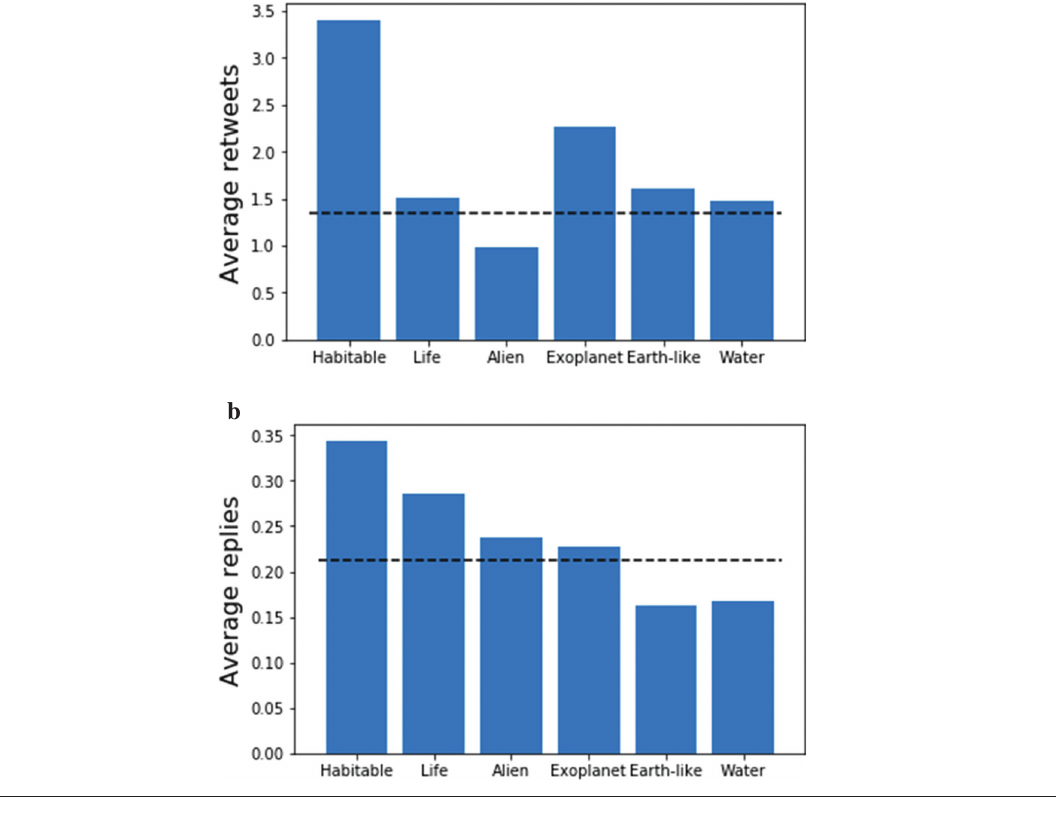
Figure 4. (a) The average number of retweets for tweets containing ‘Proxima Centauri’, containing certain keywords; (b) similar, but for replies. In each case, the dashed line indicates the average activity for all ‘Proxima Centauri’ tweets (Source: Authors, 2022)